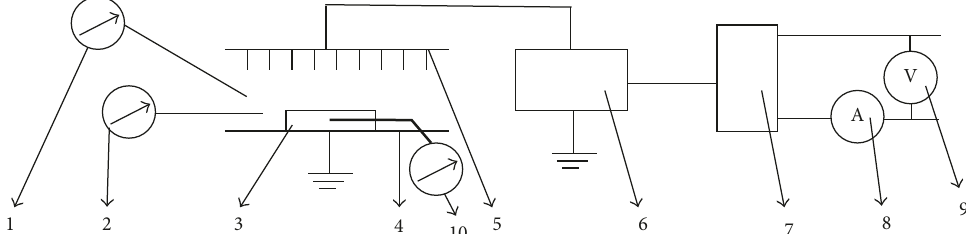
Figure 1: Schematic diagram of HVEF thawing. 1: thermometer; 2: hygrometer; 3: frozen tofu; 4: grounded plate electrode; 5: needle electrodes; 6: high-voltage power source; 7: voltage regulator; 8: amperometer; 9: voltmeter; 10: temperature